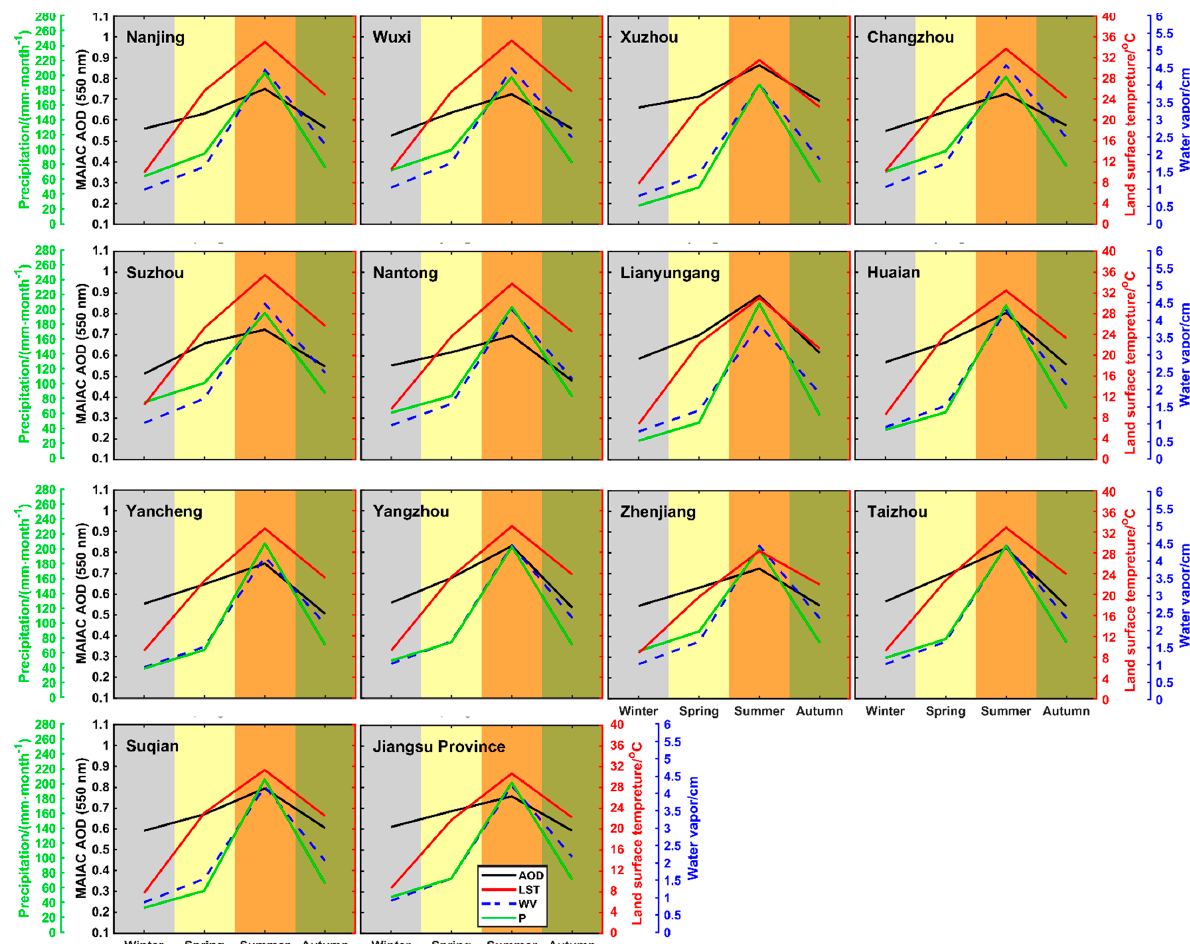
Figure 13. Meteorological impact on seasonal AOD from 2000 to 2020 in 13 cities in Jiangsu Province.